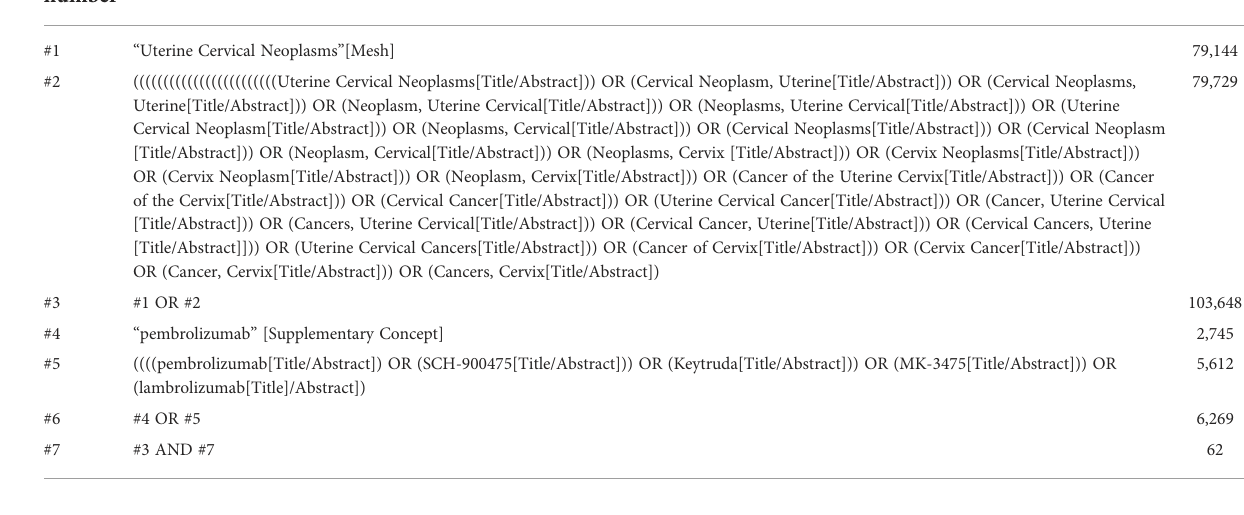
TABLE 1 Search strategy in